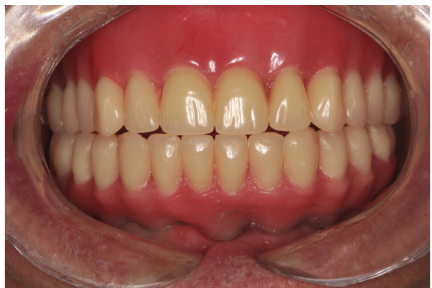
Figure 13: Complete dentures in occlusion.